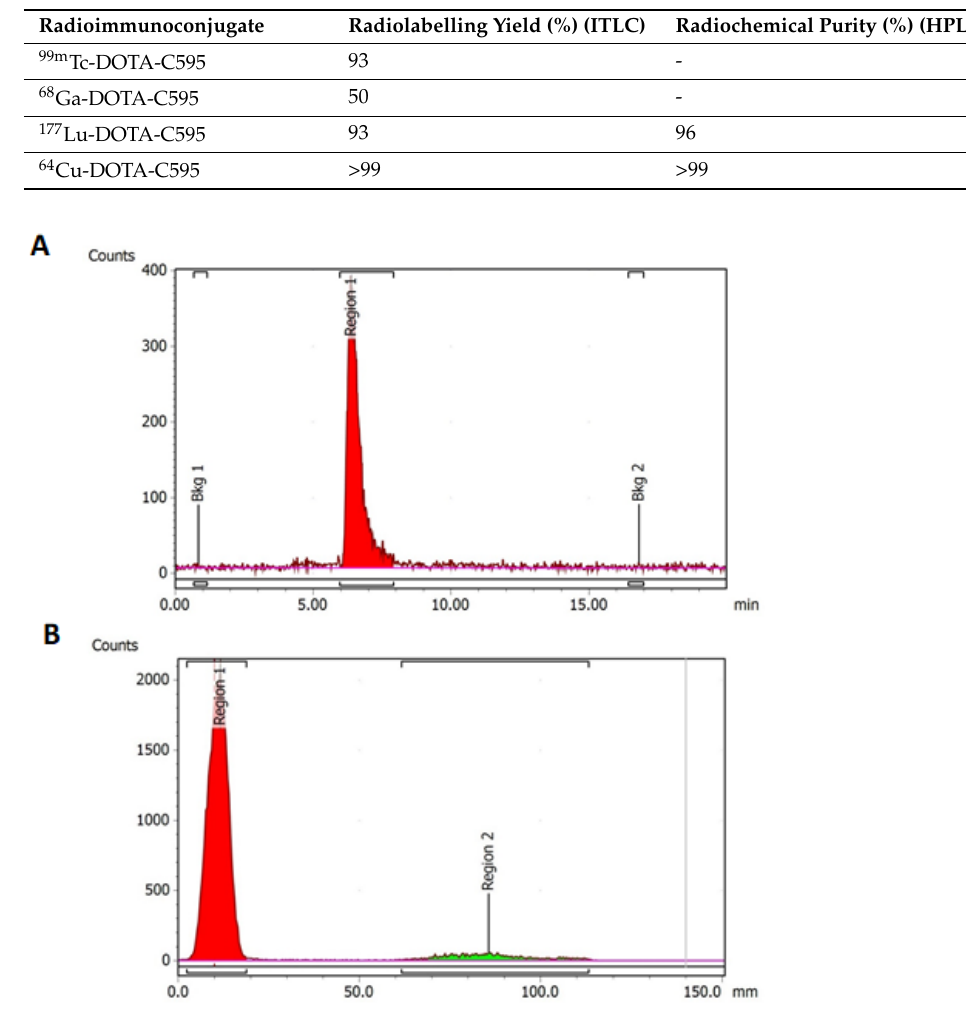
Figure 6. ( A ) HPLC radio-chromatogram of 64 Cu-DOTA-C595. Region 1 (red) represents 64 Cu-DOTA-C595 and ( B ) ITLC radio-chromatogram of 177 Lu-DOTA-C595. Region 1 (red) represents 177 Lu-DOTA-C595. Region 2 (green) represents free 177 Lu.